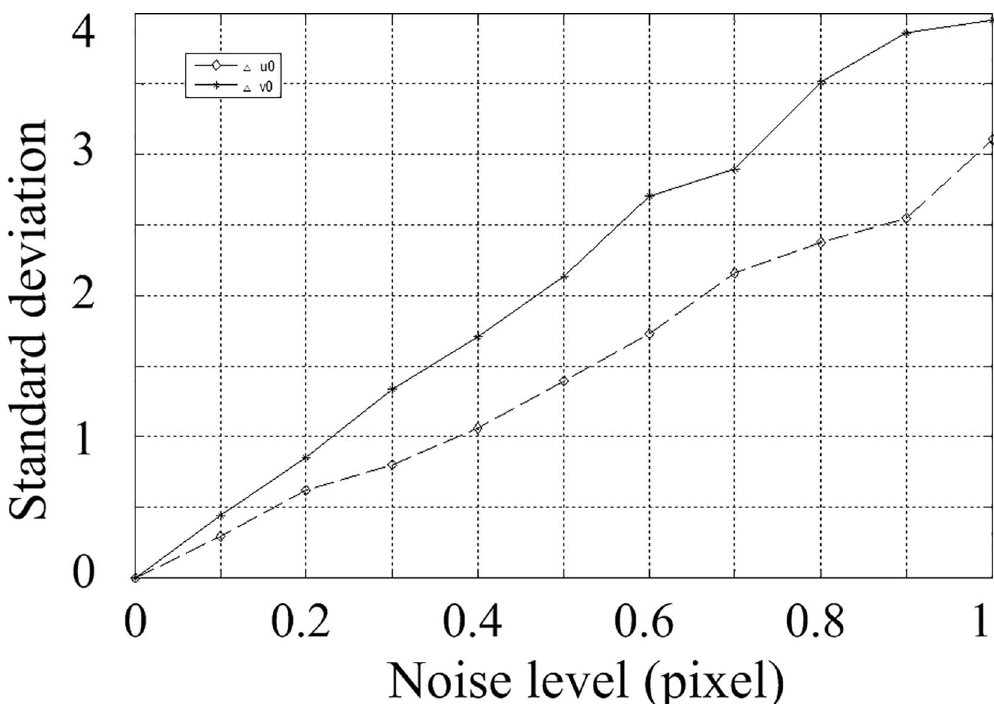
Fig 5. Standard deviations for parameters u 0 , v 0.